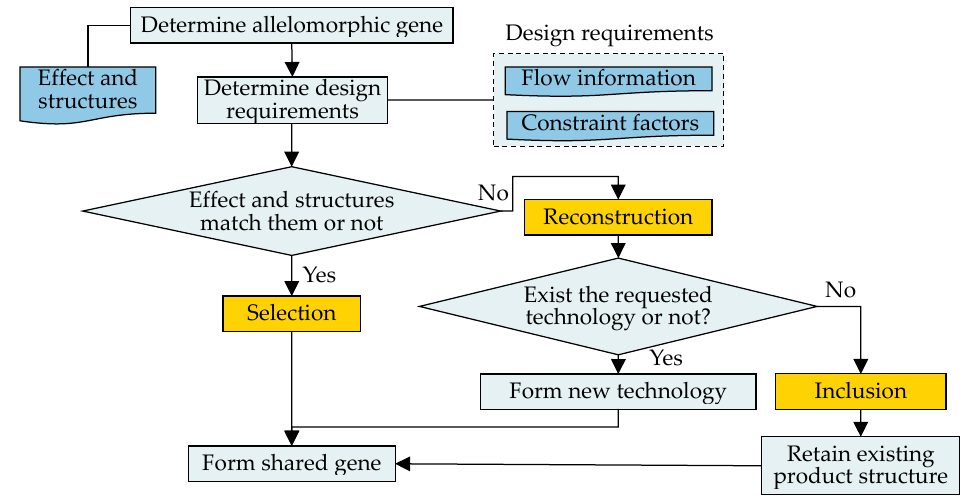
Figure 11. Process model of allelomorphic gene sharing.